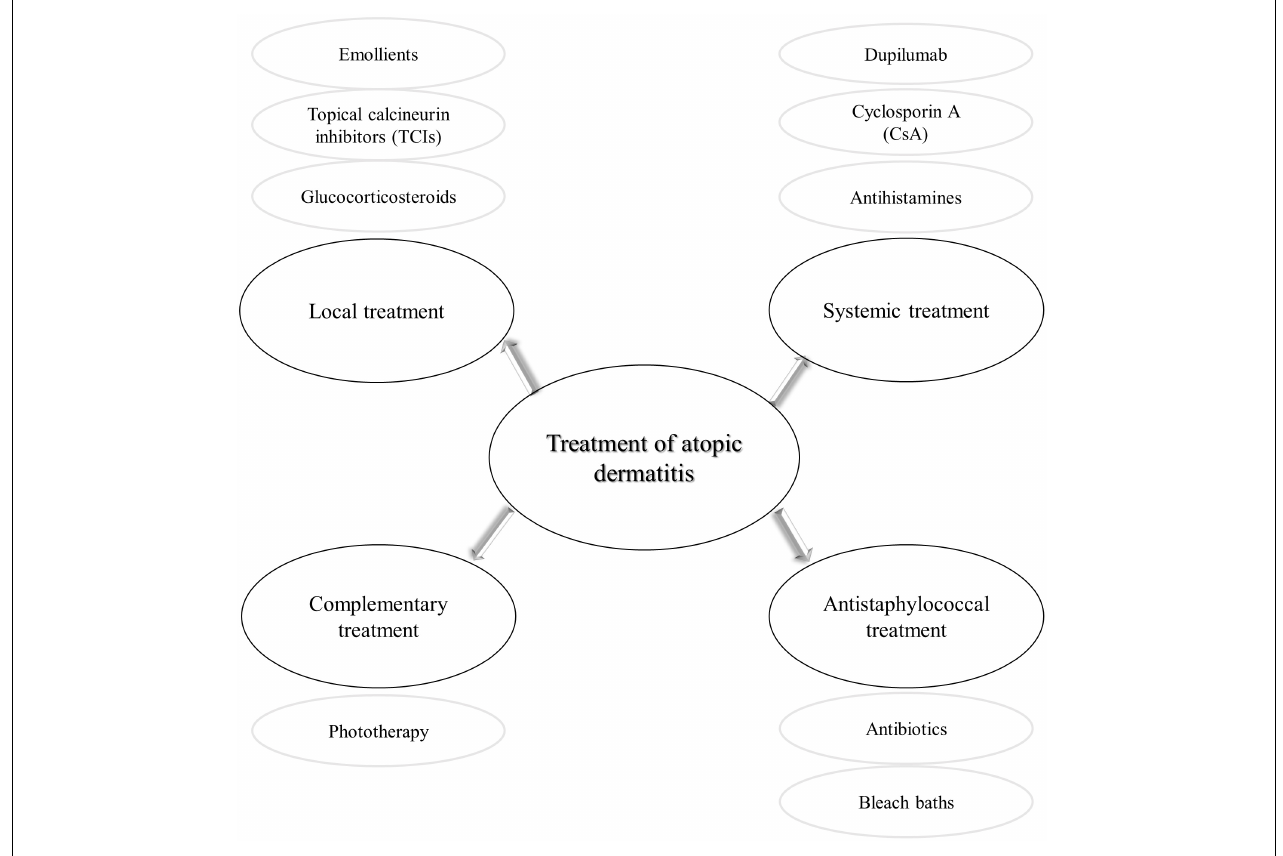
FIGURE 5 | Different types of atopic dermatitis